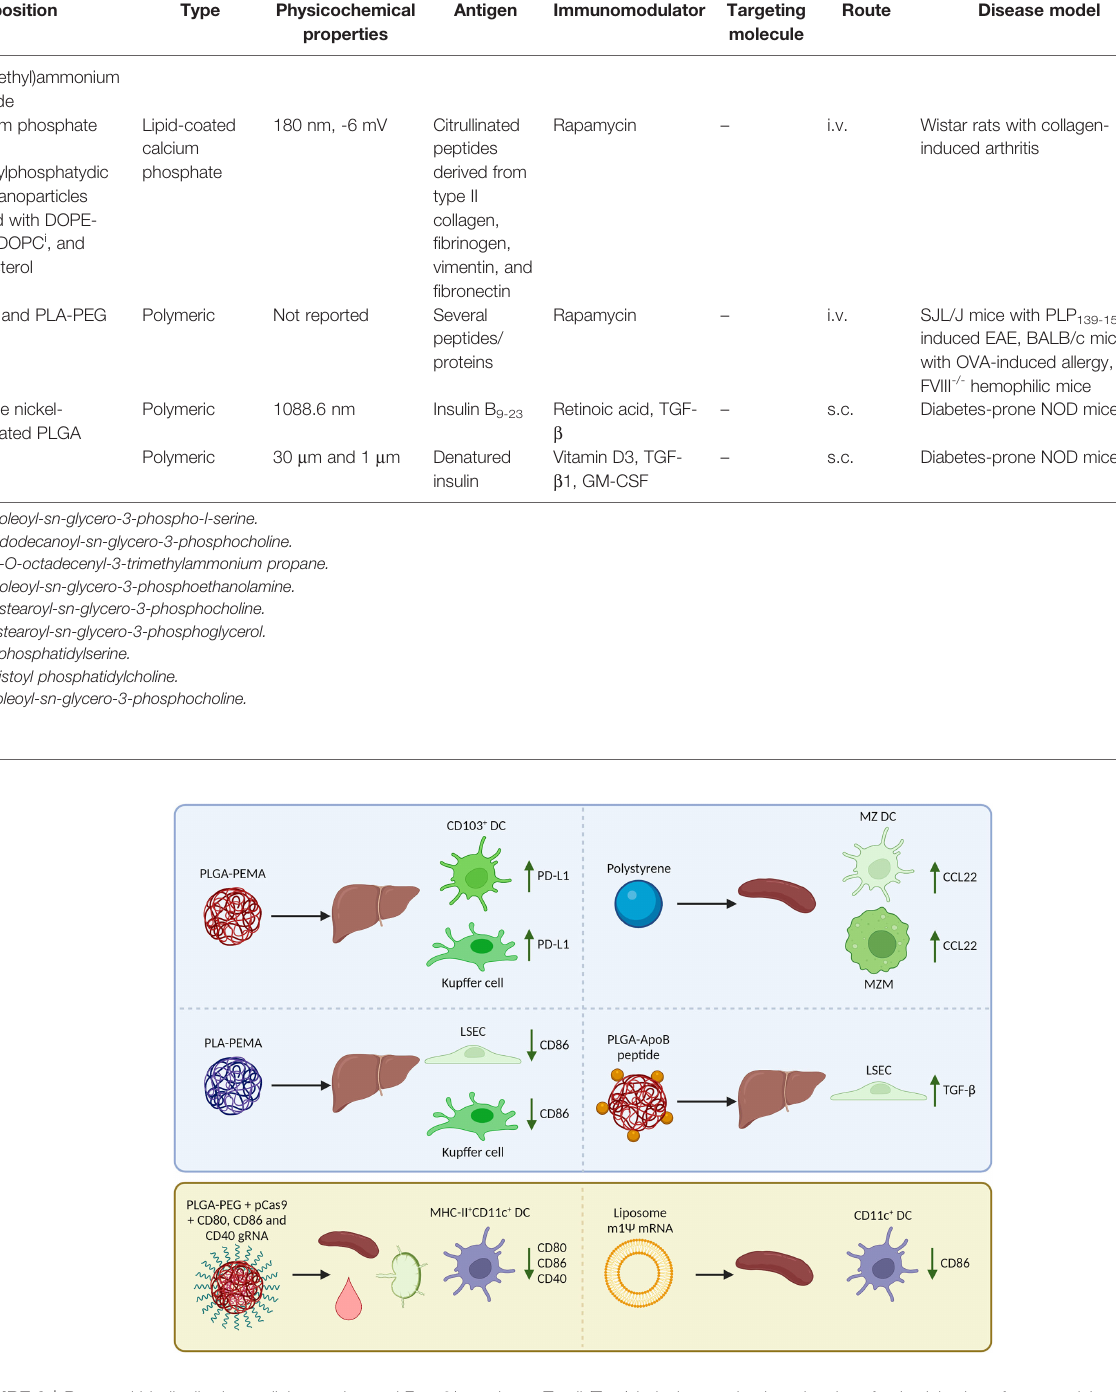
FIGURE 2 | Reported biodistribution, cellular uptake, and Foxp3 + regulatory T cell (Treg)-inducing mechanisms in mice after i.v. injection of nanoparticles encapsulating an antigen (peptide/mRNA). The blue box (top) summarizes nanoparticles that target natural tolerogenic antigen-presenting cells in the liver and spleen including dendritic cells (DCs), macrophages, and liver sinusoidal endothelial cells (LSECs) to enhance tolerance. After uptake of nanoparticles, these cells upregulate inhibitory receptors, downregulate costimulatory molecules, produce chemokines that attract Tregs, or cytokines that induce Tregs. The yellow box (bottom) summarizes nanoparticles that are taken up by a wide range of APCs including DCs in the spleen, lymph nodes, and blood. The nanoparticles are designed to inhibit co-stimulation in target cells so that the antigen can be presented in a tolerogenic manner and induce Tregs. PLGA, poly (lactic-co-glycolic acid); PLA, polylactic acid; PEMA, poly(ethylene-co-maleic acid); ApoB, apolipoprotein B; PEG, polyethylene glycol; MZ, marginal zone; m1 Y mRNA, 1 methylpseudouridine-modi fi ed messenger RNA; PD-L1, programmed death-ligand 1; CCL22, C-C motif chemokine 22; TGF- b , Transforming growth factor b